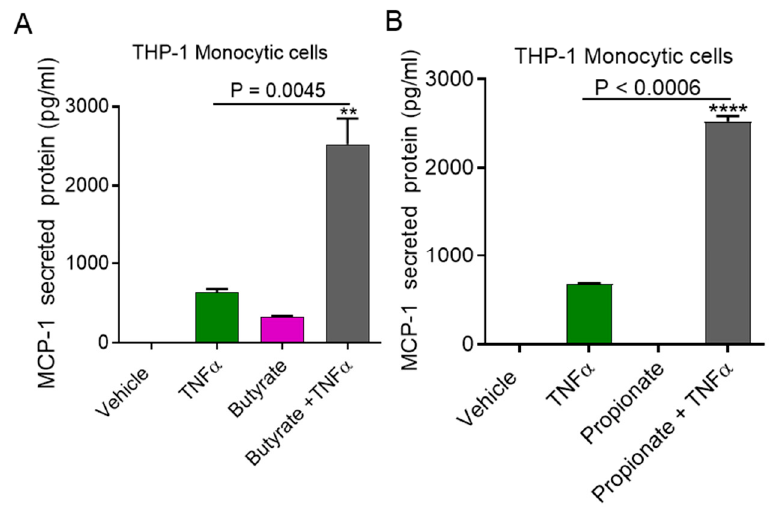
Figure 2. Impact of butyrate and propionate on TNF α induced MCP-1 expression. ( A , B ) THP-1 monocytic cells were stimulated with butyrate (2 mM), propionate (10 mM), and TNF α (10 ng/mL) alone or in combination for 24 h. Secreted MCP-1 protein in culture media was determined by ELISA. The results obtained from three independent experiments are shown. All data are expressed as mean ± SEM (n = 3). ** p < 0.01, **** p < 0.0001 versus TNF α alone.